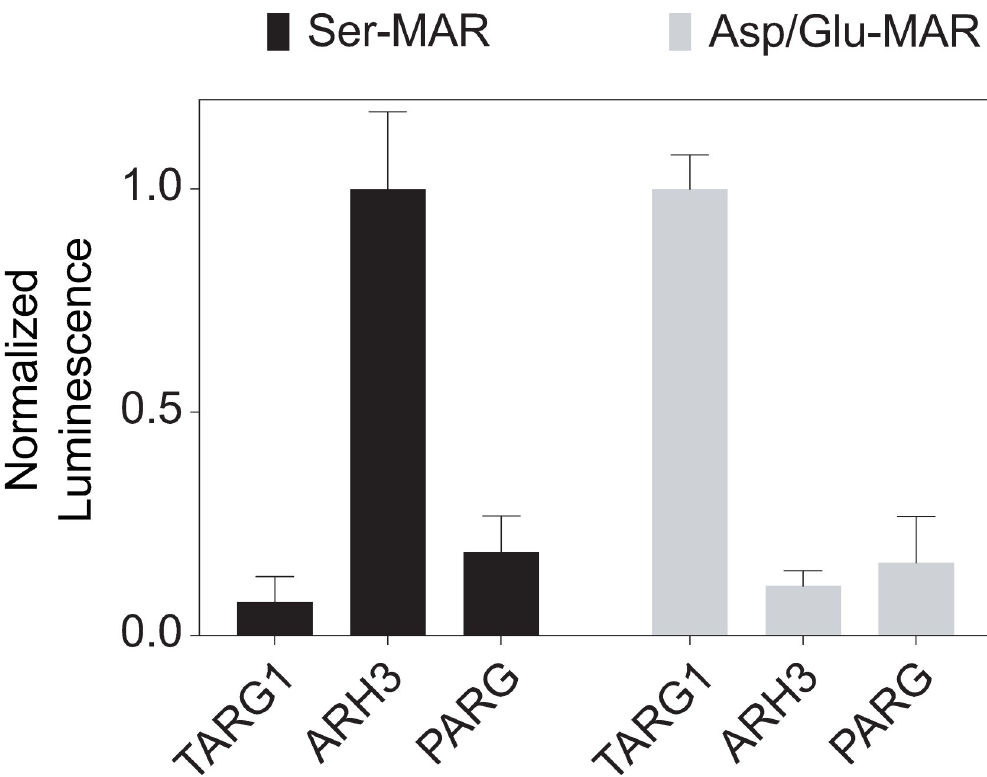
Fig 4. Monitoring of the reversal of residue-specific mono-ADP-ribosylations by ADP-ribosyl-acceptor hydrolases using the NCAG assay. The Ser- and Asp/Glu-MARylated PARP1 substrates (see the “Materials and Methods”) were digested with 2 μ M TARG1, ARH3, and PARG, and released ADP-ribose was measured using the NCAG assay. While PARG shows limited hydrolysis of MARylated substrates, ARH3 and TARG1 specifically reverse the Ser- and Asp/Glu- MARylation, respectively. The luminescence signals from different enzymes were normalized with respect to that from ARH3 (in Ser-MAR) and TARG1 (in Asp/Glu-MAR), respectively. Standard deviations from triplicates were calculated for all NCAG assays and are shown as error